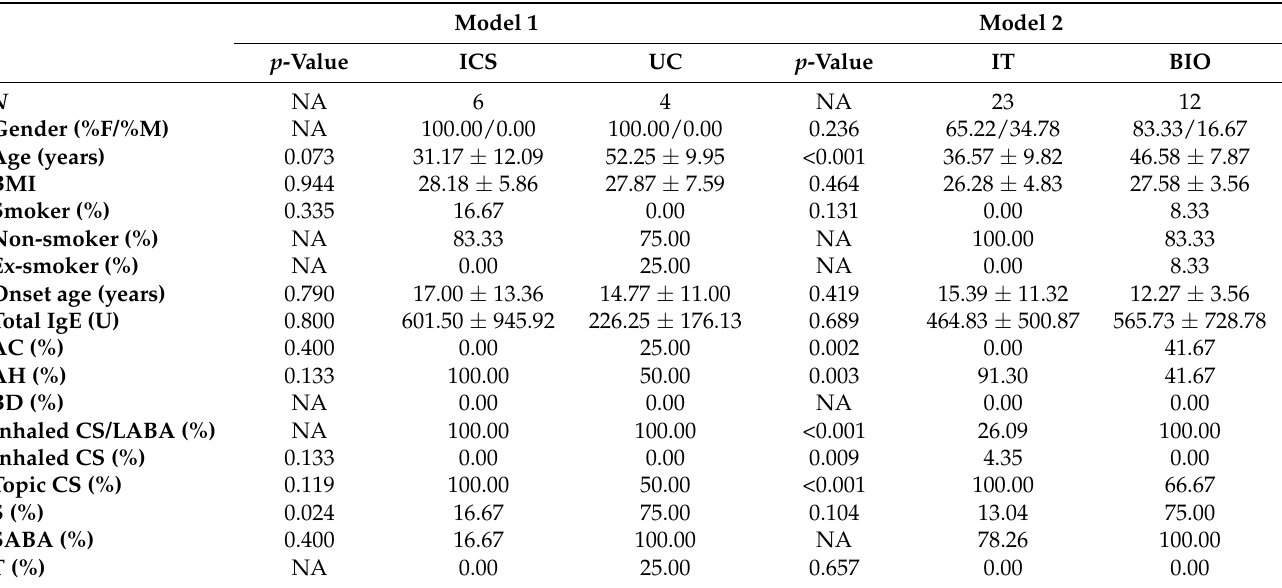
Table 5. Clinical information of patients included in the